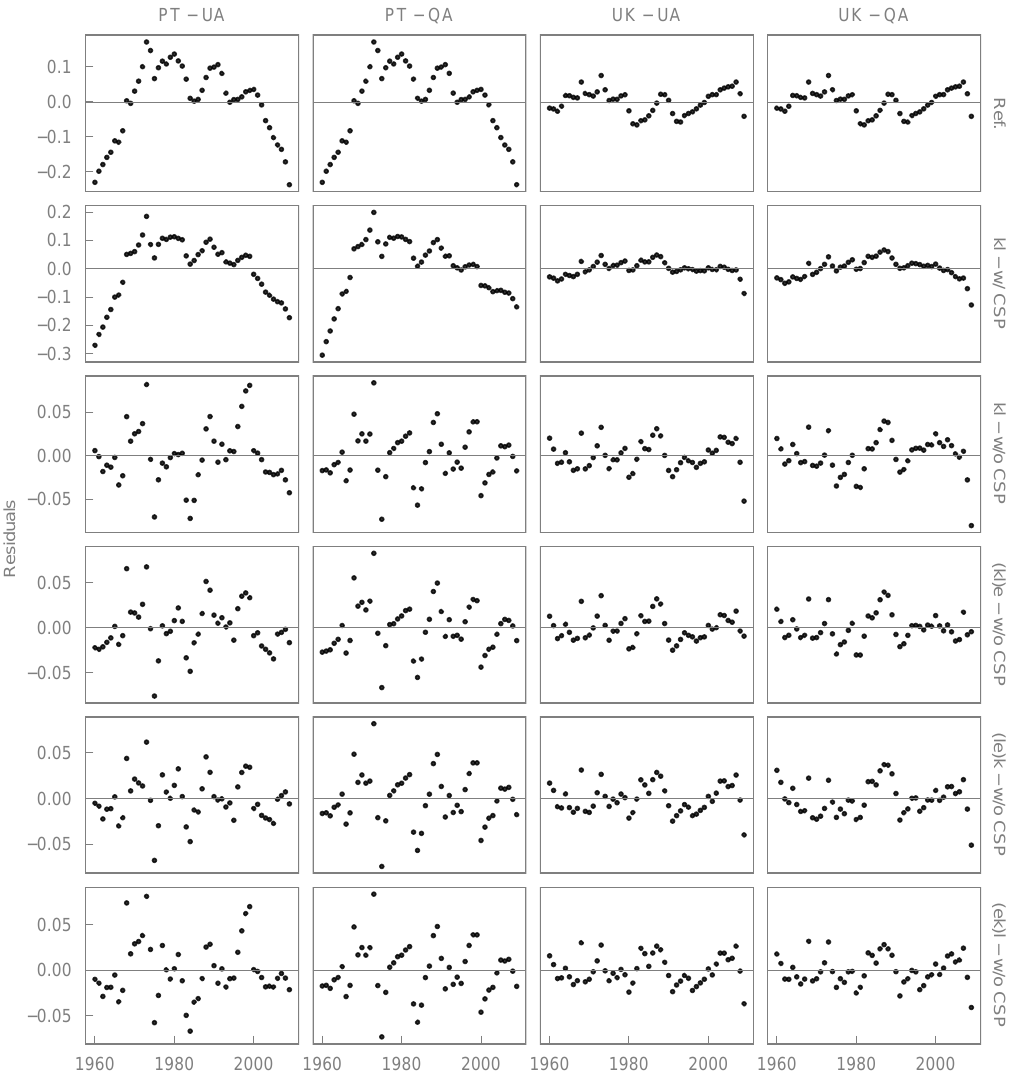
Figure A1. Residuals for all modeling approaches. Note the different scale for “w/o CSP”